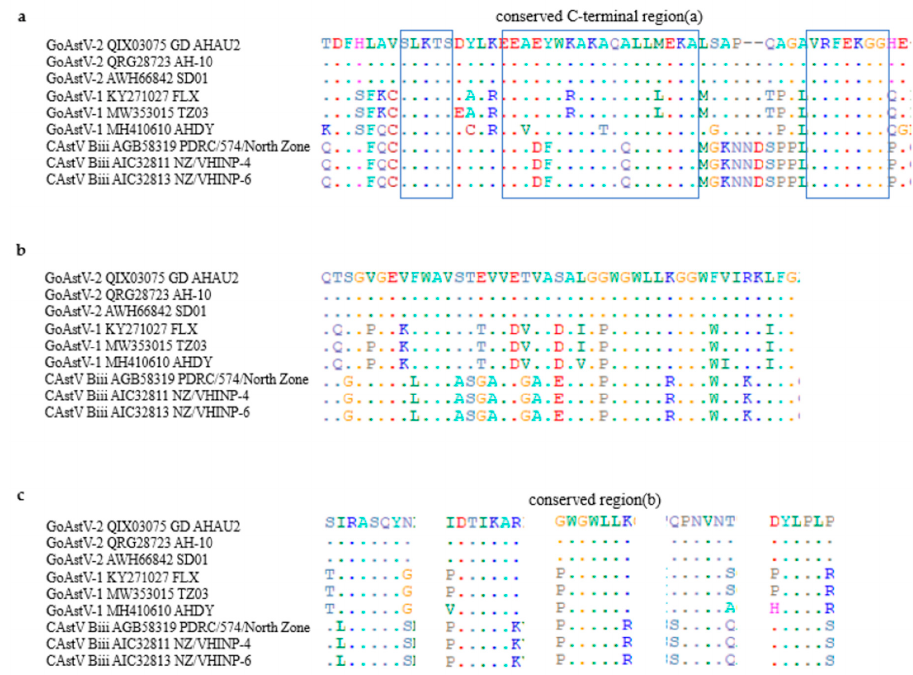
Figure 4. Clustal W alignment of the complete of the capsid proteins of nine representative isolates (subgroup Biii CastVs(3), subgroup GoAstV-1(3) and subgroup GoAstV-2(3)). The PDRC/574/North